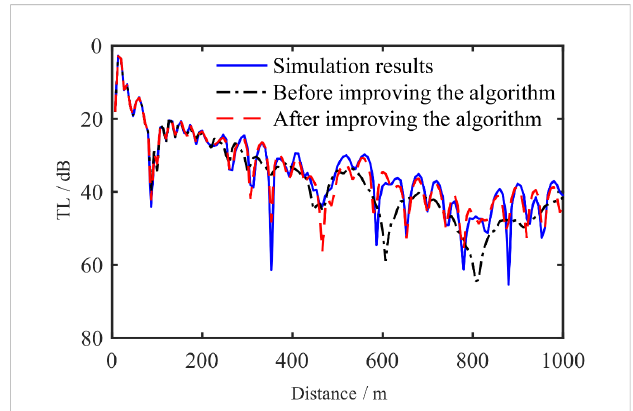
FIGURE 8 Comparison of transmission loss of inversion parameters before and after improvement of the algorithm.